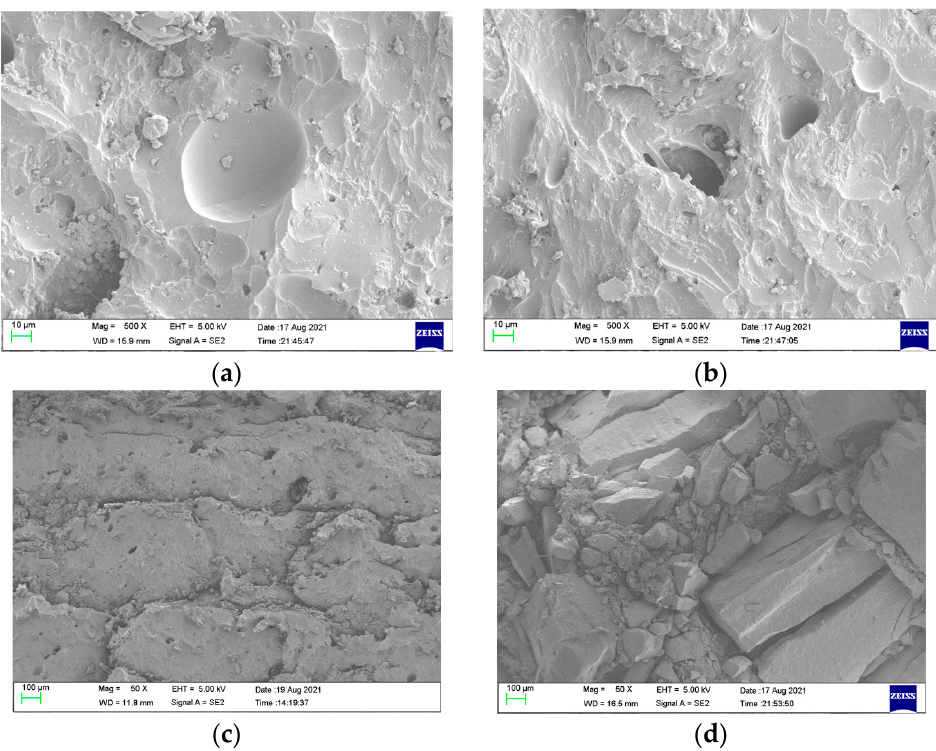
Figure 8. SEM images of polyurea on the target of configuration M. ( a ) Hole. ( b ) Deformation hole. ( c ) Stepped cracks. ( d ) Ceramic debris.